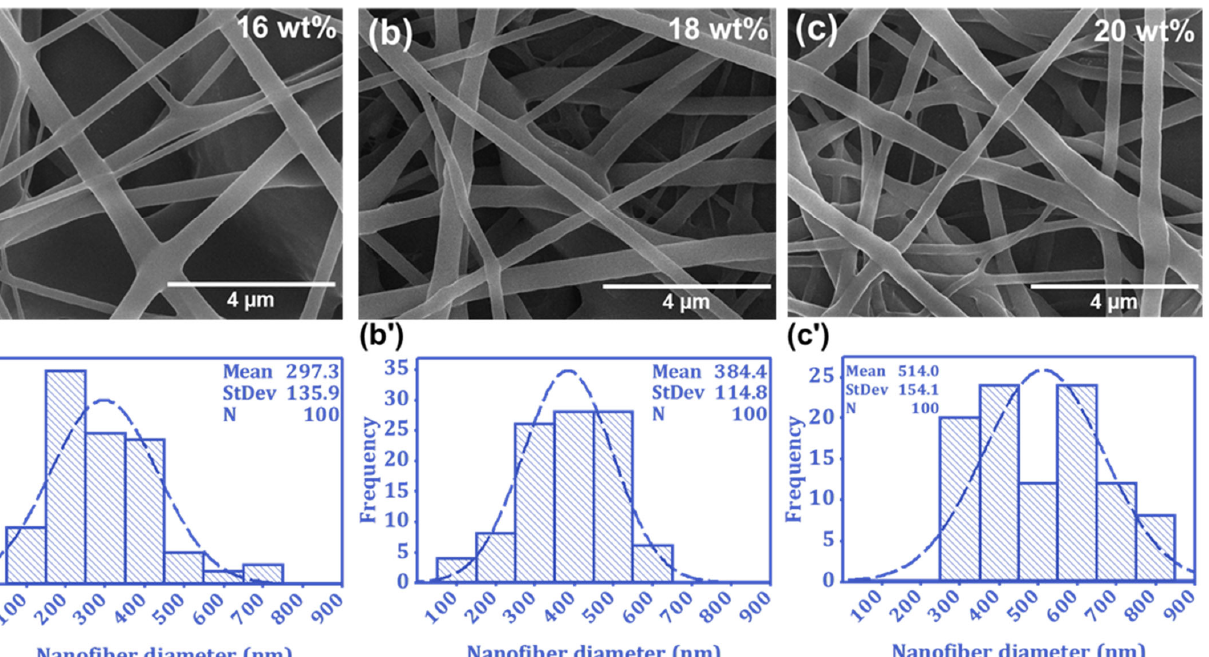
Figure 3a–c. In contrast, process parameters, such as applied voltage, fl ow rate, and spin- ning distance, were held constant at 25 kV, 1.0 mL/h, and 20 cm, respectively. The results indicated that beadless electrospun fi bers were formed with all three polymer concentra- tions, with mean diameters of 297 ± 136, 384 ± 115, and 514 ± 154 nm of the PU − NFs noted at concentrations of 16, 18, and 20 wt%, respectively. Notably, the concentration of the PU signi fi cantly impacts the diameter of the PU-NFs, as the diameter of the fi ber is signi fi - cantly increased when the concentration of the PU polymer increases. This fi nding is con- sistent with previous reports that documented an increase in fi ber diameter with an in- crease in polymer concentration [43]. The diameter histograms (Figure 3a ′ –c ′ ) reveal that electrospun fi bers with a narrow diameter distribution are fabricated at an 18 wt% PU concentration, whereas electrospun fi bers with a wider diameter distribution are obtained at 16 wt%. Furthermore, coarser fi bers are formed at 20 wt% with a wide diameter range. Therefore, the 18 wt.% of PU polymer solution was considered the optimized sample and selected for the electrospun fi ber membrane. The microscopic structure of the composite SiO 2 @PU − NFs membrane, composed of 6% SiO 2 -NPs and 18% PU concentration, was studied using SEM, as given in Figure 4a. The electrospraying process was una ff ected by the fi ber diameter distribution and a tt ributed to the nanoparticle deposition on the surface of the PU-NFs. In addition, it can be seen in the SEM images that the SiO 2 -NPs are deposited throughout the surface of the composite PU-NFs. Figure 4a ′ shows a histogram of the fiber diameters’ distribution of the optimized SiO 2 @PU-NFs, composed of 6% SiO 2 -NPs and 18% PU concentration. The mean diameter of the composite electrospun fibers is 394 ± 105 nm, respectively, having a narrow uniform diameter distribution. Moreover, the high-resolution SEM image of the SiO 2 @PU-NFs reveals the presence of nanoparticles on the surface of the electrospun fibers (Figure 4b).